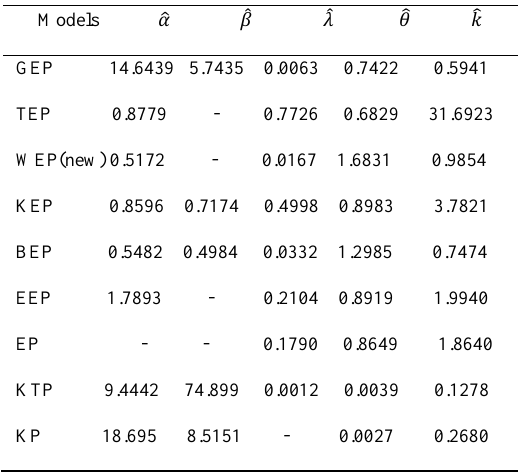
Table 3. Maximum likelihood estimates-Wheaton river data Models